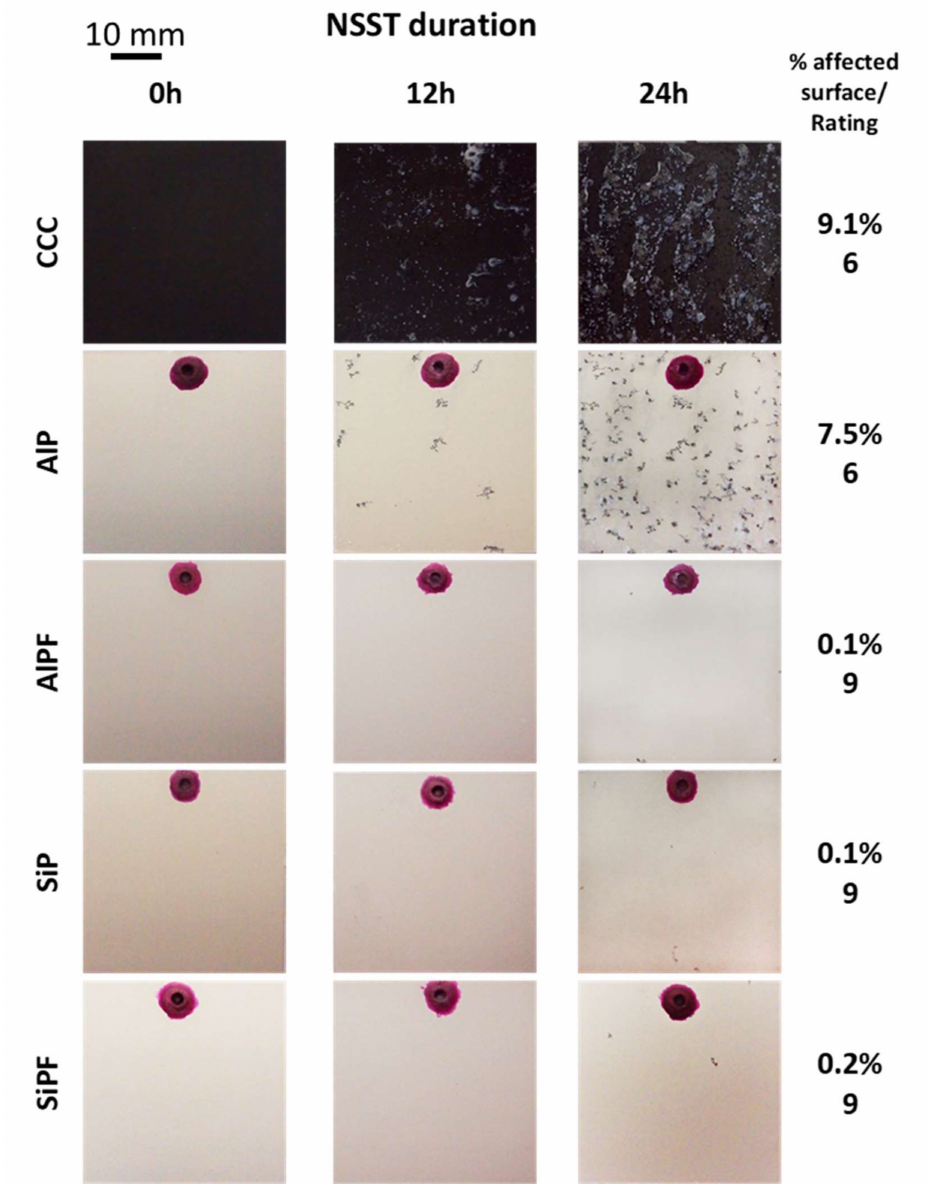
Figure 3. Macrographs of selected FPEO coatings and CCC before and after NSST of unpainted samples. Rating according to ASTM D 1654 calculated after 24 h (average of three